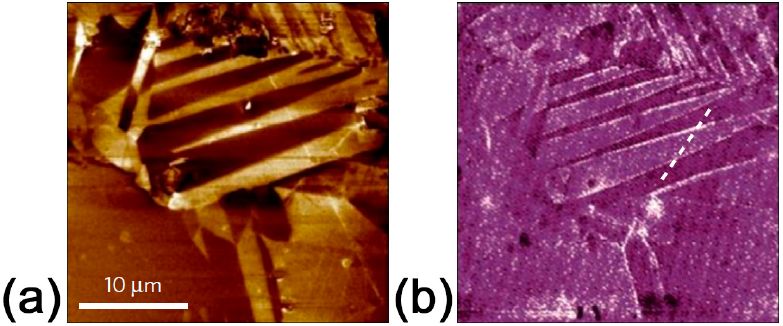
Figure 15. ( a ) Out-of-plane PFM amplitude and ( b ) conductive atomic force microscopy (c-AFM) images of selected regions with domains in BiFeO 3 annealed in O 2 atmosphere. Adapted from [7], with permission from © 2016 Nature Publishing Group.